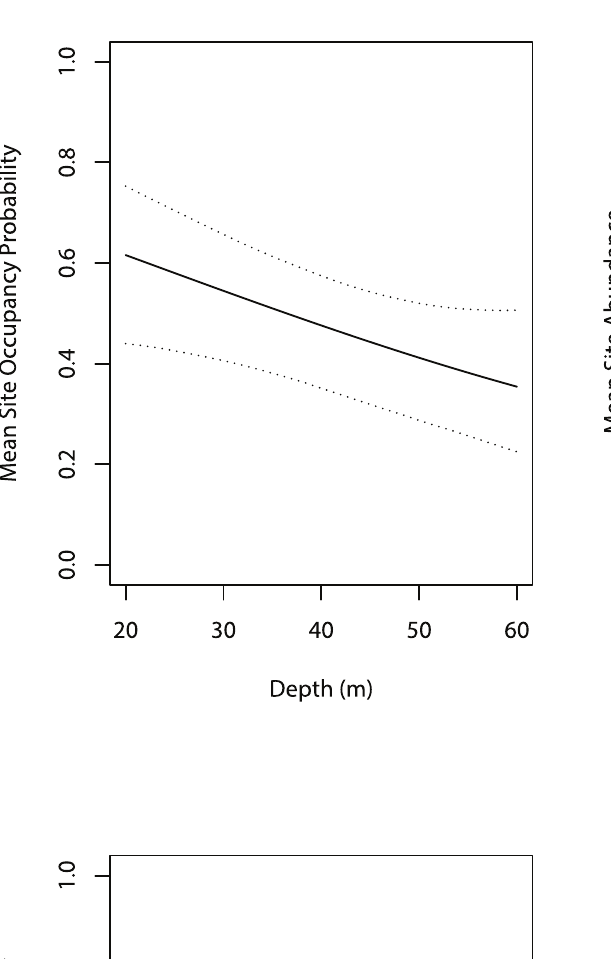
Figure 3. Mean site occupancy probability and abundance of red snapper as a function of depth and latitude. The left column contains the estimated mean site occupancy probability as a function of depth (top panel) and latitude (bottom panel) from the basic occupancy model. The right column contains the estimated mean site abundance as a function of depth (top panel) and latitude (bottom panel) from the Royle-Nichols occupancy model. The intervals represent 95% credible intervals.